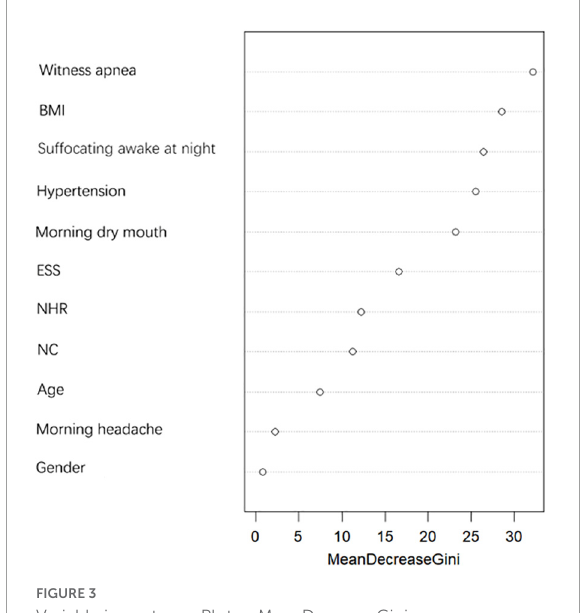
FIGURE3 Variable importance Plot — MeanDecreaseGini.